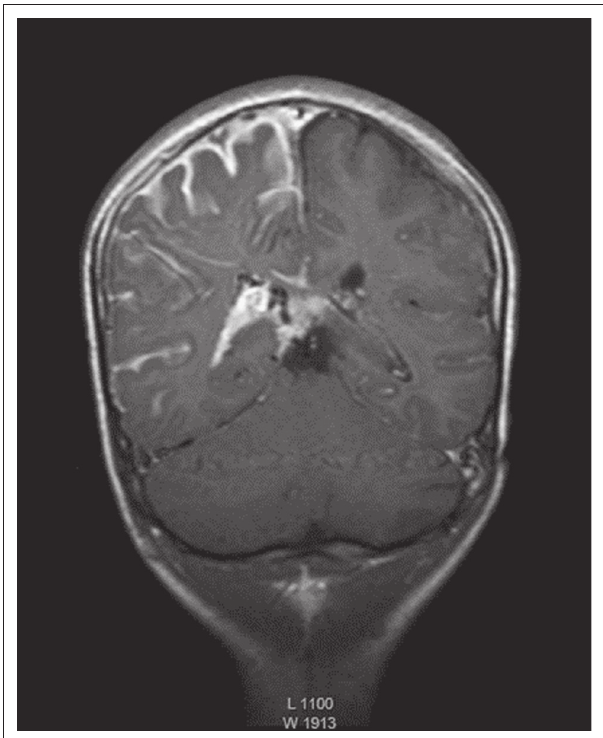
Source : Farhana E. Suleman FIGURE 2: Coronal T1 post gadolinium image demonstrating enhancement of the left choroidal angioma, marked pial enhancement of the right cerebral hemisphere and intense enhancement and enlargement of the right choroid plexus, in keeping with active disease in the right hemisphere. No contrast enhancement is seen in the left hemisphere in the regions of the calcifications, in keeping with ‘burnt out’ disease on the